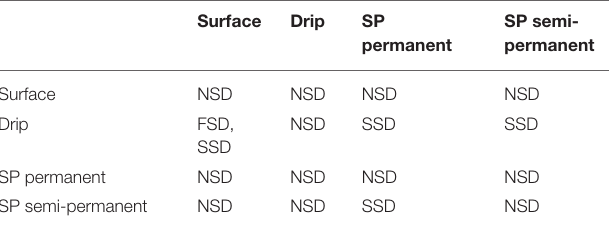
TABLE 5 | First- and second-degree stochastic dominance analysis for forage corn crops.